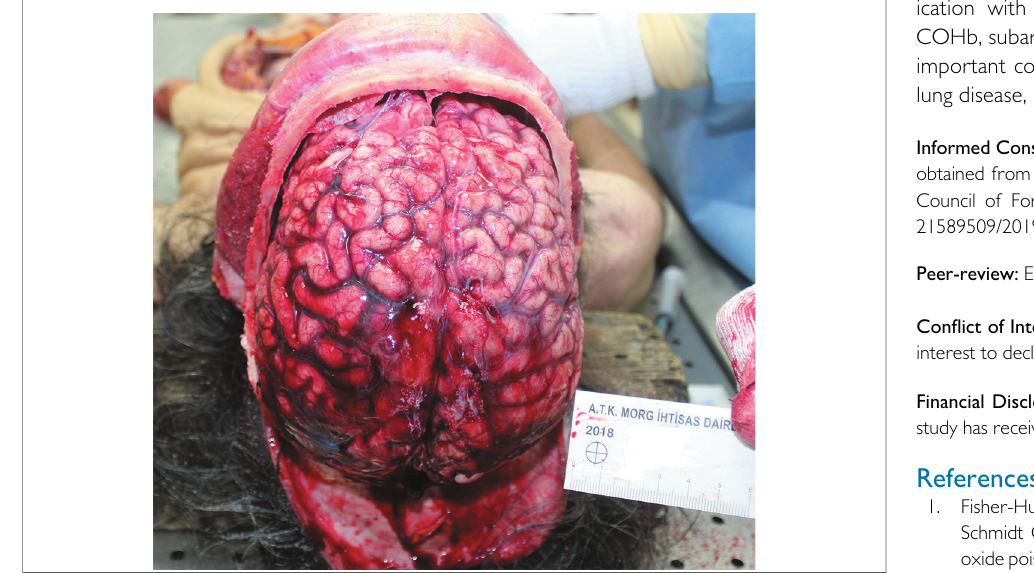
Figure 1. Subarachnoid